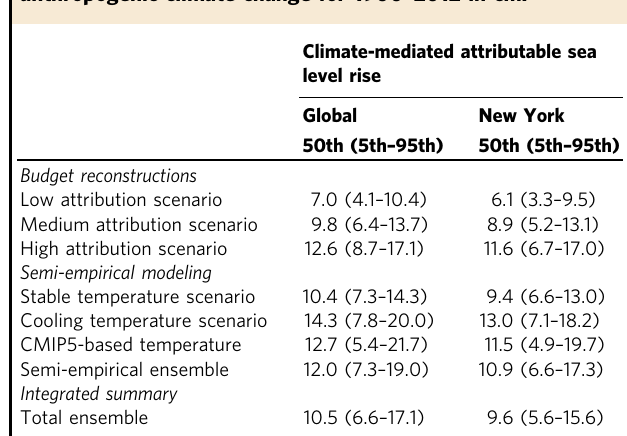
Fig. 1 Modeled and attributable changes in global mean sea level (GMSL) from 1900 to 2012. a Semi-empirically modeled historical GMSL estimates, based on global temperature timeseries from HadCRUT4 (observations) and from the CMIP5 historical scenario (simulations). b Semi-empirically modeled counterfactual GMSL estimates, from temperature-based stable or cooling counterfactual scenarios, and from the CMIP5 natural scenario. c Estimates of anthropogenic sea level rise (ASLR), based on differences between matching scenarios: HadCRUT4 vs. stable or cooling temperatures, and historical vs. natural CMIP5 simulations. Curves re fl ect medians of results pooled across semi-empirical model calibrations for both long-term temperature reconstructions 29,30 ; shaded regions indicate 5th – 95th percentile ranges. Also included are the medians (points) and 5th – 95th percentiles (vertical bars) of historical (panel a ) and central-case attributable (panel c ) sea-level-rise budgets (Supplementary Table 3). Observed GMSL from ref. 7 over 1900 – 2012 (median and 5th – 95th percentiles) is also shown for comparison (panel a ; Supplementary Table 1). Table 1 Estimates of sea level rise attributable to anthropogenic climate change for 1900 – 2012 in